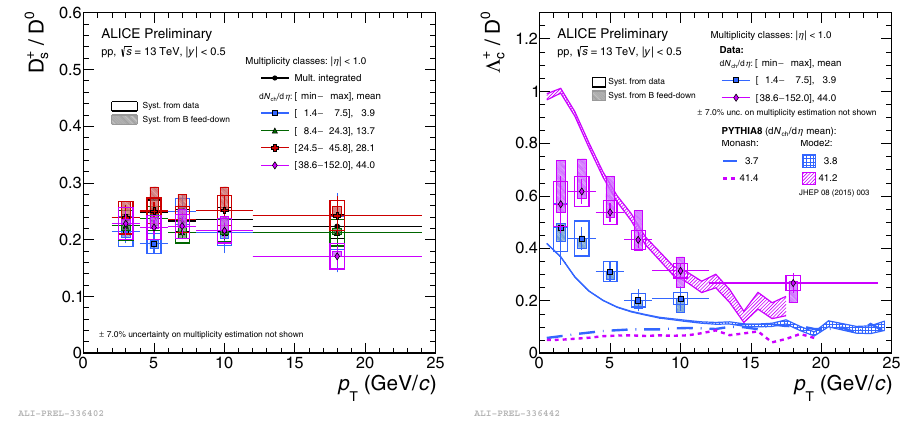
Figure 1. D + s / D 0 (left panel) and Λ + c / D 0 (right panel) ratio as a function of transverse momentum ( p T ) in di ff erent charged-particle multiplicity intervals in pp collisions at √ s = 13 TeV. not show any dependence on charged-particle multiplicity within uncertainty and their abun- 43 42 dance is compatible with the average of the p T -integrated measurements performed in e − e + 44 collisions at LEP [3]. However, the Λ + 45